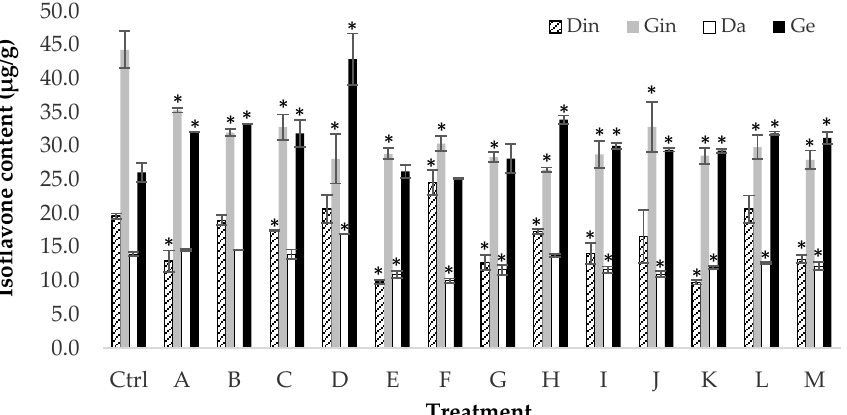
Figure 2. Individual isoflavone content (μg/ g) of soymilk prepared from PEF-HSB. * Indicates significant difference ( p < 0.05) between soymilk obtained by PEF-HSB at specific treatment conditions and control soymilk. Ctrl : Soymilk obtained from conventional extraction process. A : E = 2 kV/cm, n = 10; B : E = 10 kV/cm, n = 10; C : E = 2 kV/cm, n = 100; D : E = 10 kV/cm, n = 100; E : E = 2 kV/cm, n = 55; F : E = 10 kV/cm, n = 55; G : E = 6 kV/cm, n = 10; H : E = 6 kV/cm, n = 100; I – M : E = 6 kV/cm, n = 55.